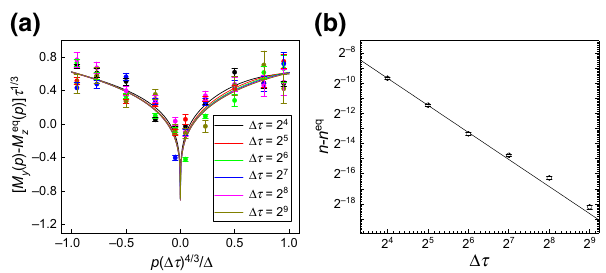
FIG. 4. The Kibble-Zurek scaling for a higher-order EP. (a) The data collapse for the momentum-resolved defect density for different ramp times τ . The dots with error bars refer to the experimental measurements and the solid lines depict the exact numerical solution. (b) The total defect density as a function of the ramp time τ exhibits algebraic behavior. The solid line rep- resents the best power-law fit to the experimental data, with the fitted exponent α = 1.80 ( 5 ) . By moving further away from EP4, deviations from the ideal scaling for larger values of p would appear. This can be attributed to the additional EP2s at infinity, which imply levels that are very close to each other pairwise for any finite p , leading to interlevel